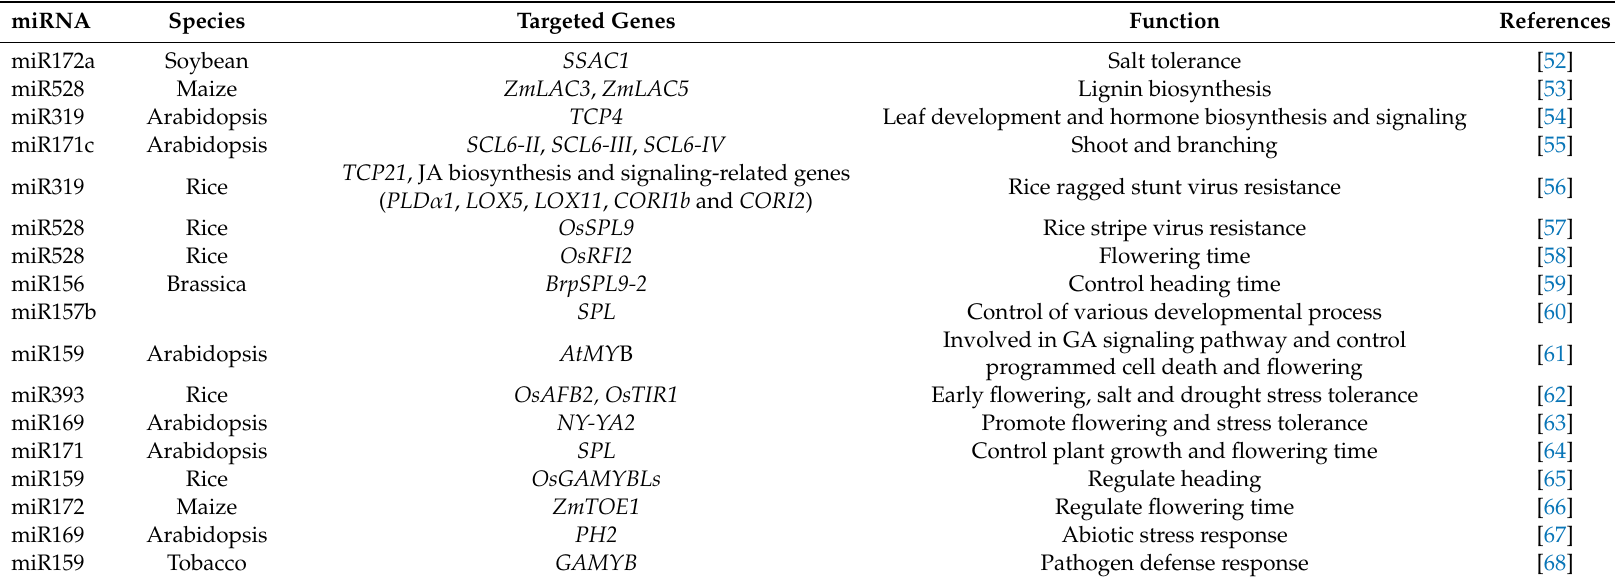
Table 1. List of miRNAs involved in plant growth and